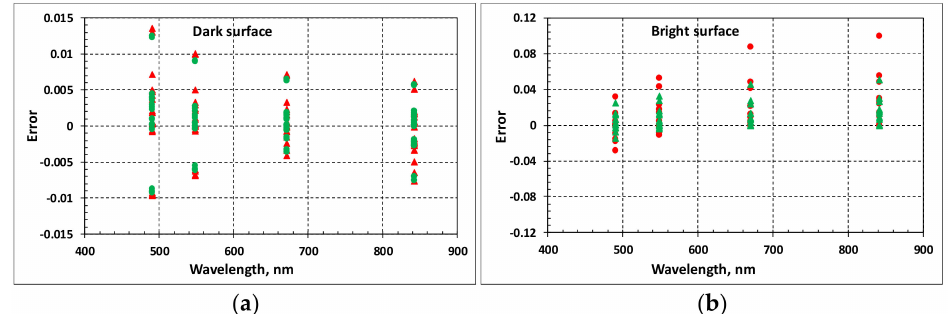
Figure 6. Errors in retrieving surface spectral reflectance in the MZ channels for dark surfaces ( a ) and bright surfaces ( b ) at solar zenith angles 60 ◦ (red circles) and 20 ◦ (green